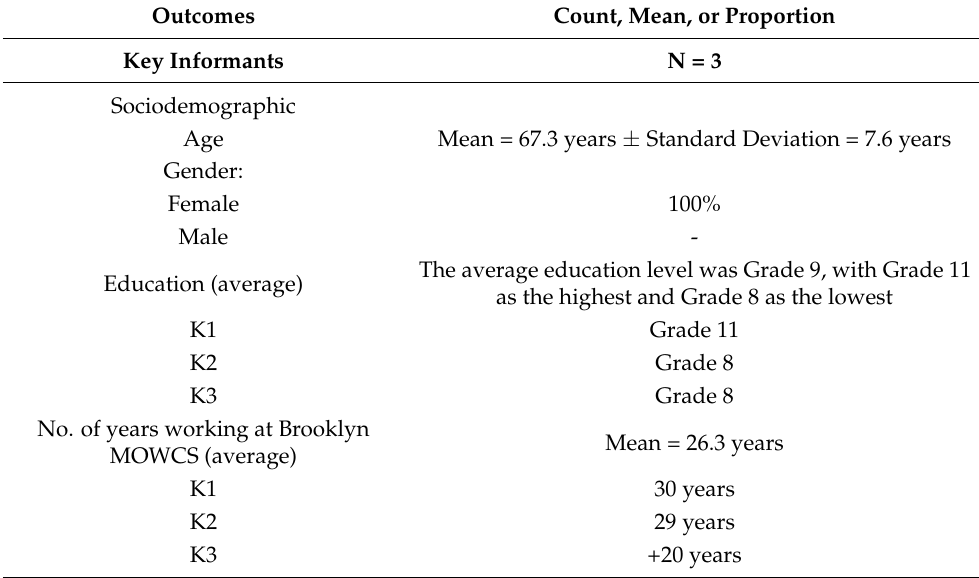
Table 2. Key personnel’s demographic